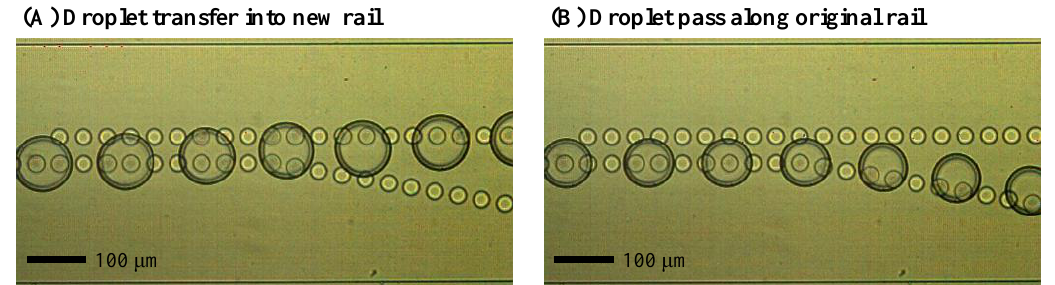
Figure 5. Different droplet routes and transfer behavior in the dot rail according to size and outer boundary. The time interval between each droplet is 0.3 s. ( A ) Transferring of large droplets into the new rail; ( B ) Guiding of small droplets along the original